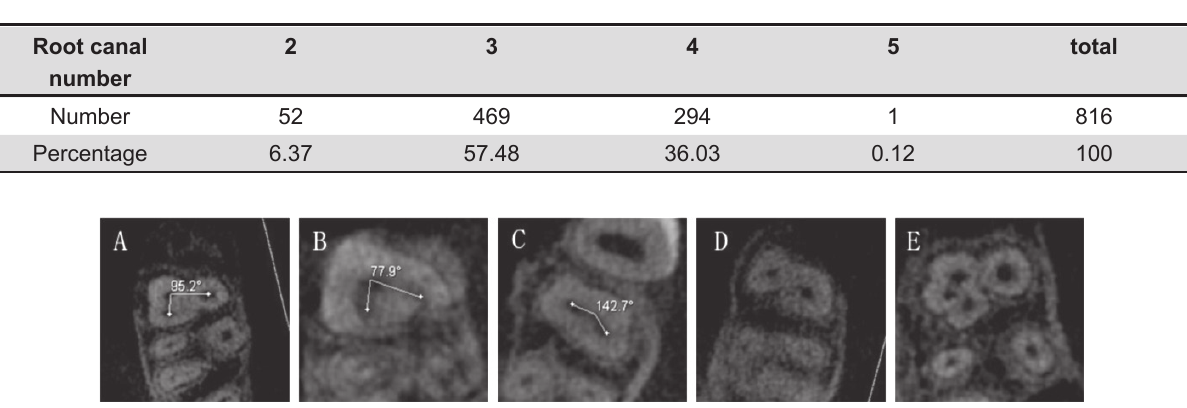
Table 1- Number and percentage of the separated root canals related to the root canal anatomy of the maxillary second molar